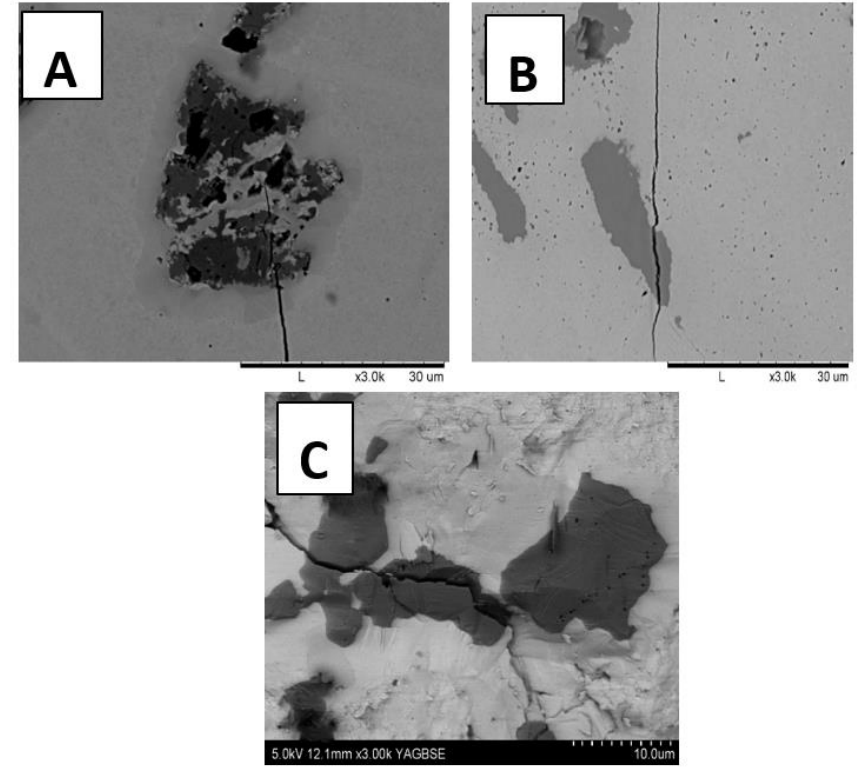
Figure 9. SEM images of ZrO 2 -Ti composite obtained by slip casting method: ( A ) crack propagation in area of complex distribution of Ti particles mixed with ZrO 2 particles in ZrO 2 matrix; ( B , C ) cracks passes through the Ti particle, bridging by Ti particles. Source: results obtained under supervision of K. Konopka .